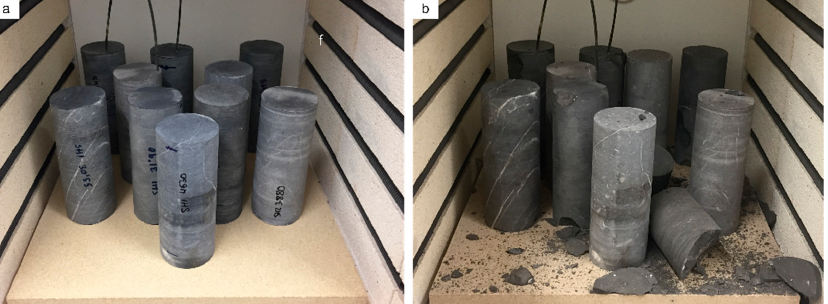
Figure 8. Samples before ( a ) and after ( b ) heated to 600 °C. Effects of temperature involve visible fissure growth, splitting, and cracking. fissure growth, splitting, and